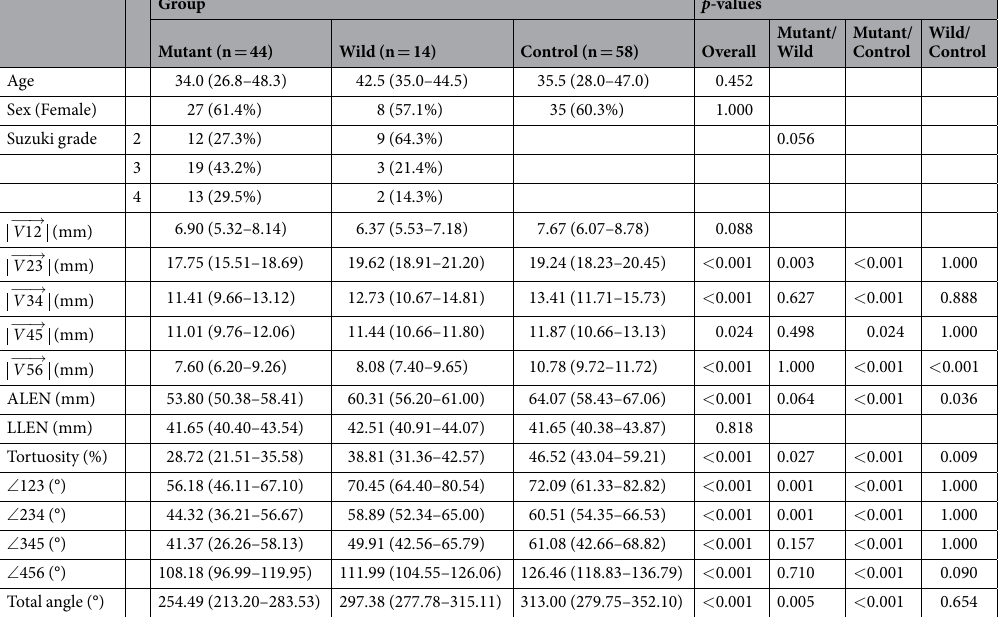
Table 1. Data summary. Suzuki grade, presented as number (percent), was analyzed by Fisher’s exact test between the mutant and wild-type group. The proportion of female patients is presented as number (percent), and it was analyzed by Fisher’s exact test among the three groups. Other variables are presented as median (interquartile range) and were analyzed by the Kruskal–Wallis test with Bonferroni’s corrections for statistical difference. V12, vertical petrous segment; V23, horizontal petrous segment; V34, vertical cavernous segment; V45, horizontal cavernous segment; V56, intracranial segment; ALEN, actual length; LLEN, linear length; ∠ 123, inter-petrous angle; ∠ 234, petro-cavernous angle; ∠ 345, inter-cavernous angle; ∠ 456 siphon